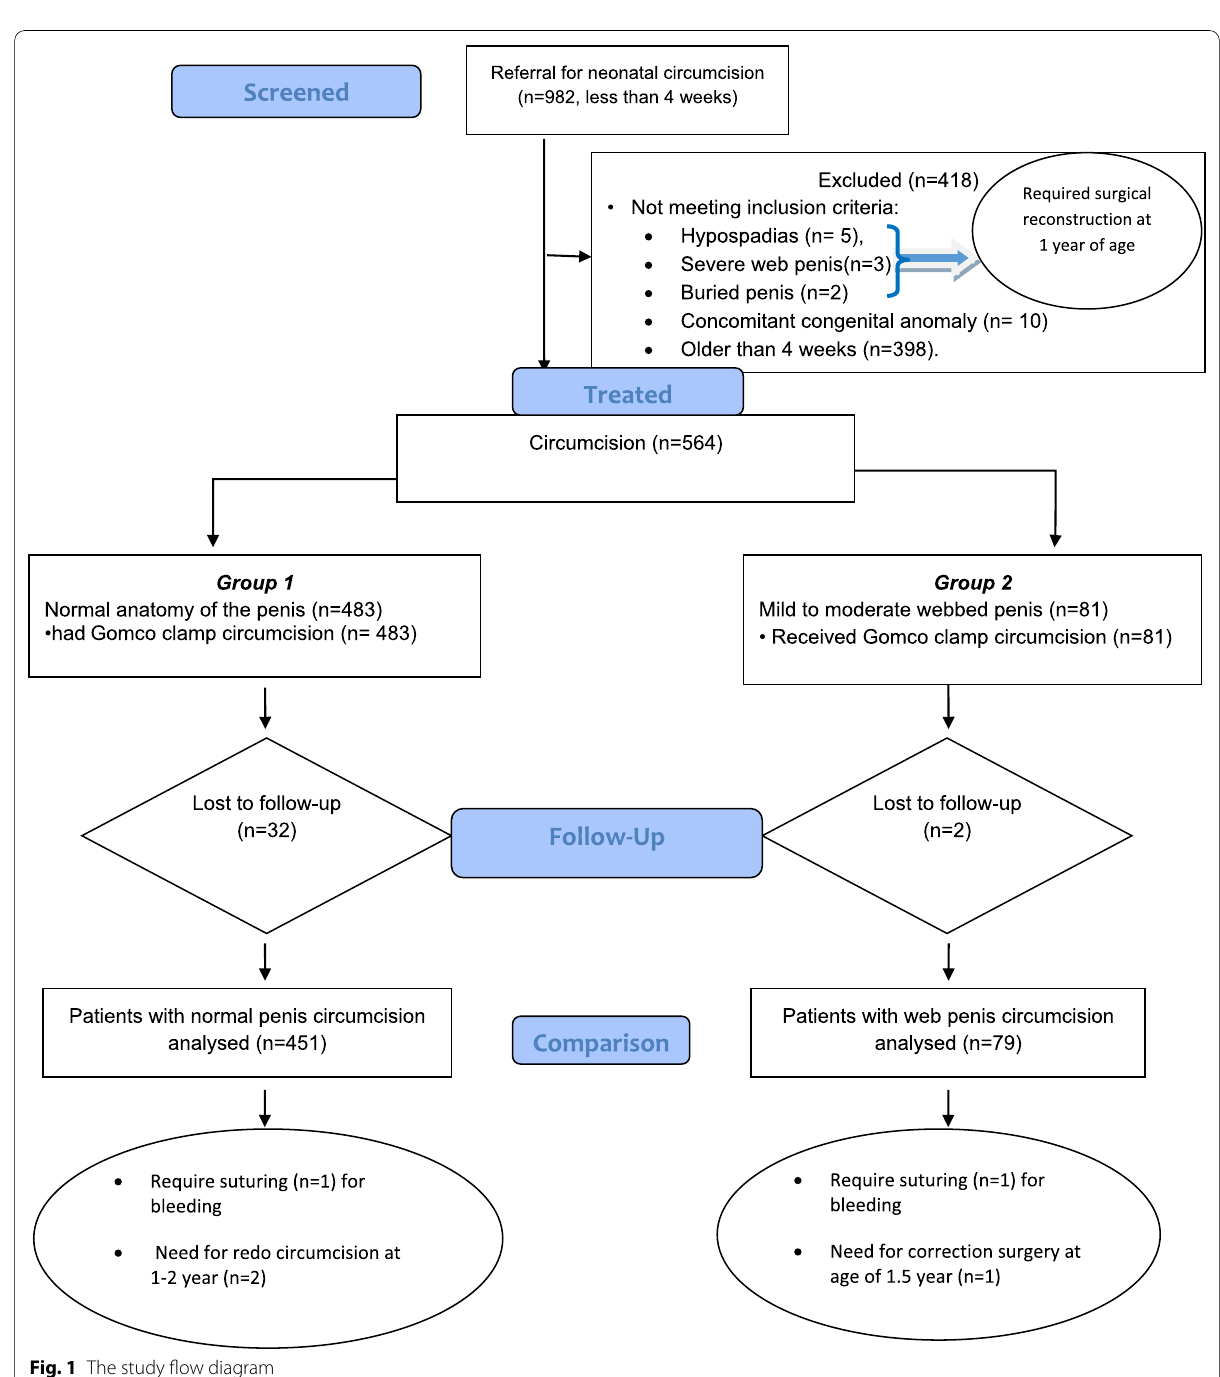
Fig. 1 The study flow